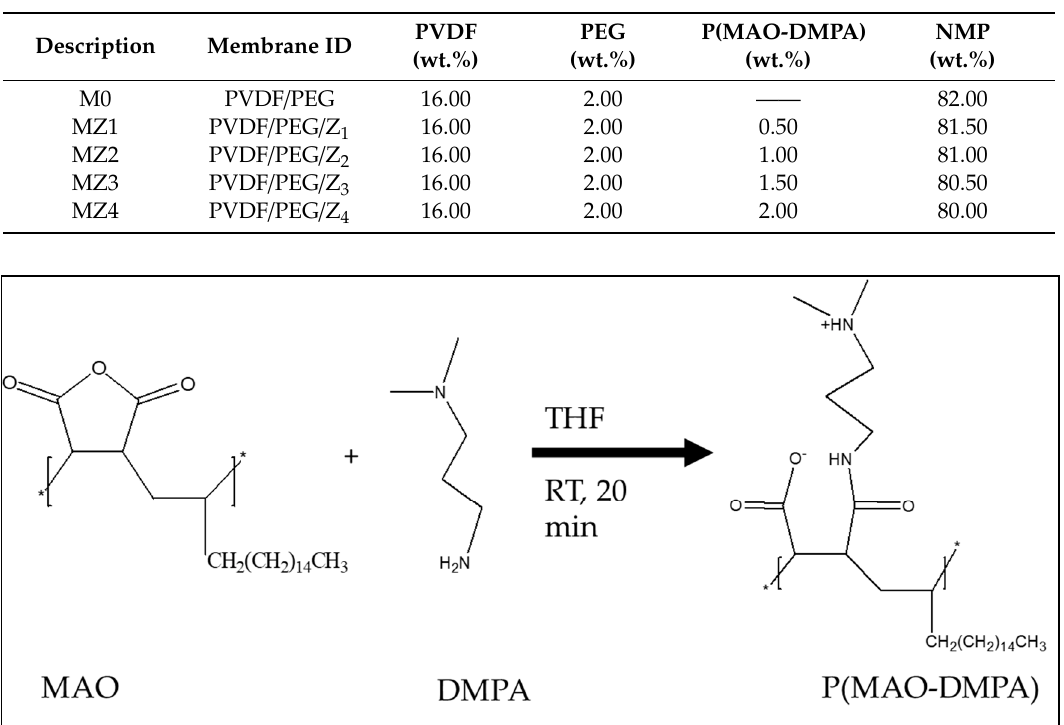
Composition (wt.%) of the membrane casting solutions. PVDF: poly(vinylidene fluoride); PEG: poly(ethylene glycol); p(MAO-DMPA): poly-(maleic anhydride-alt-1-octadecene-3-